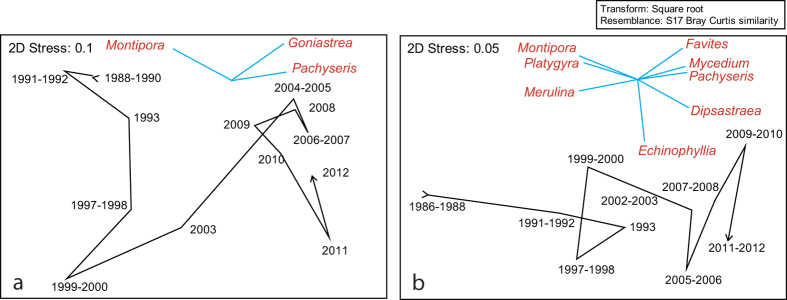
Changes in coral community structure (average of sites) over time visualized as two dimensional non-metric Multidimensional Scaling Plots (nMDS) for shallow (a) and deep (b) sites. Data are square root transformed and 2D stress is reported. The star diagrams show vectors for cover of coral taxa that correlated most strongly with change (Pearson correlations >0.7).